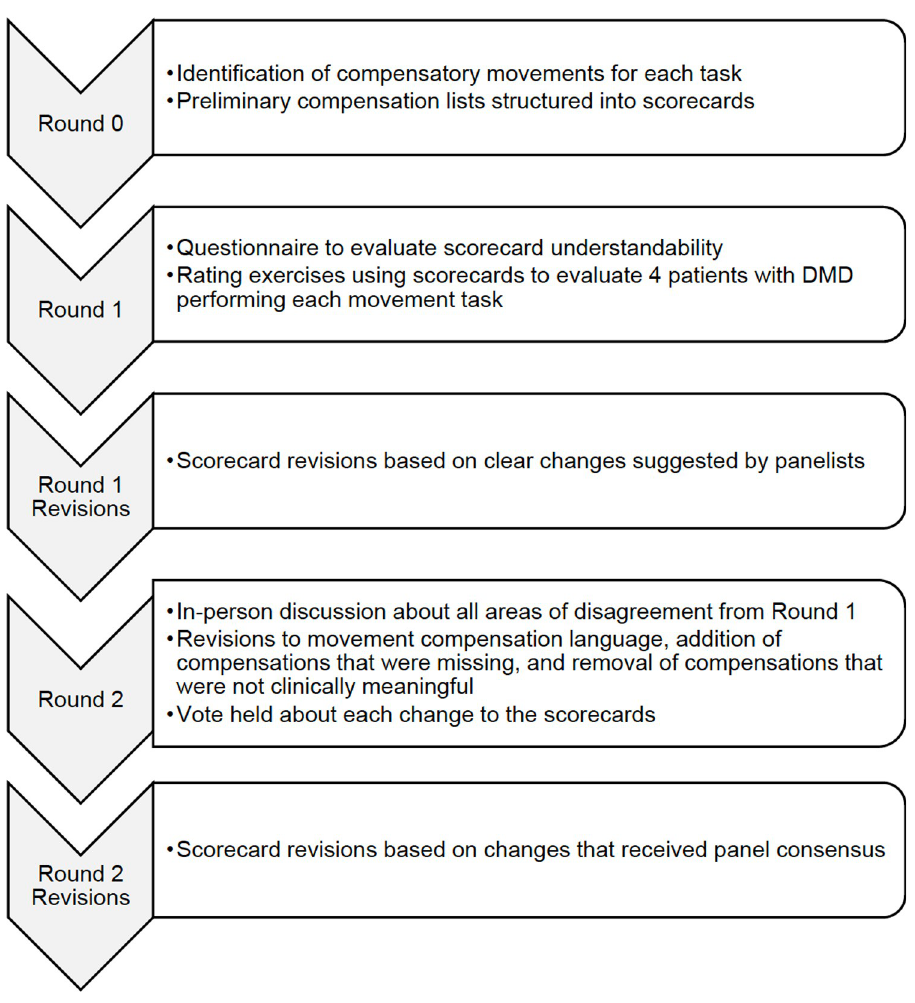
Fig 2. Modified Delphi process